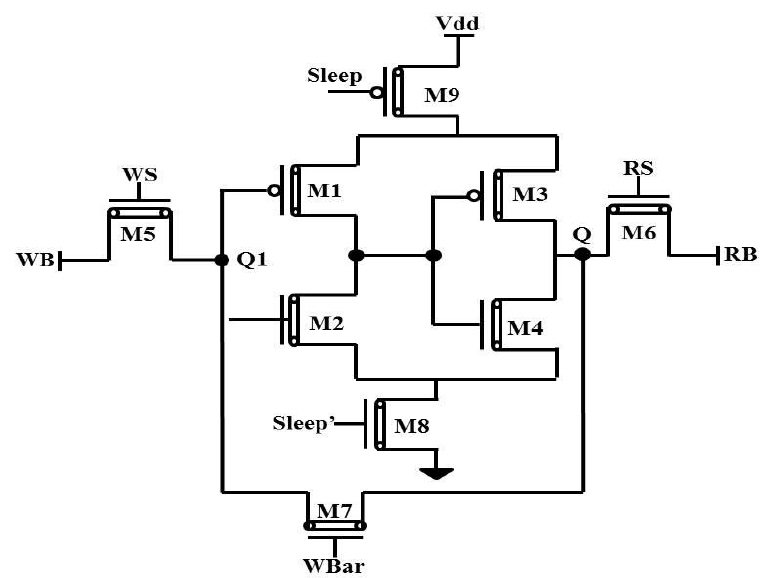
Figure 8. CNFET-Multi-Threshold 7T-SRAM Figure 8. CNFET - Multi - Threshold 7T - SRAM cell. Figure 8. CNFET - Multi - Threshold 7T - SRAM cell.